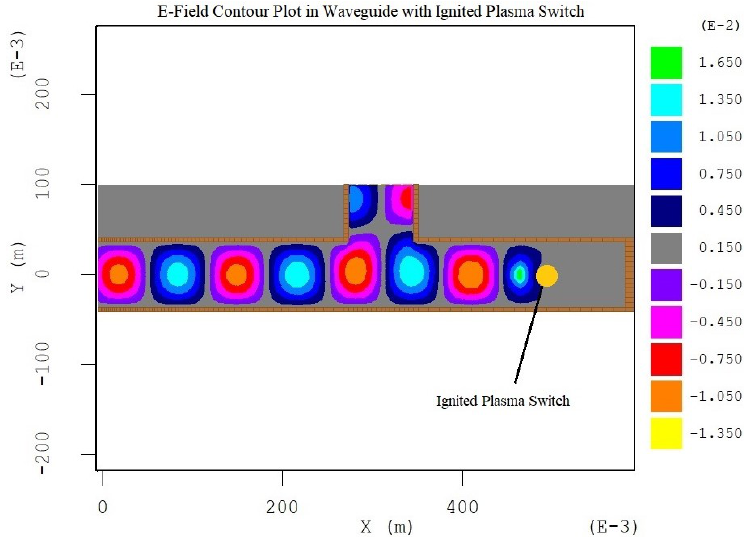
Figure 2. Standing wave reflection after RF–beaminteraction. Discharge